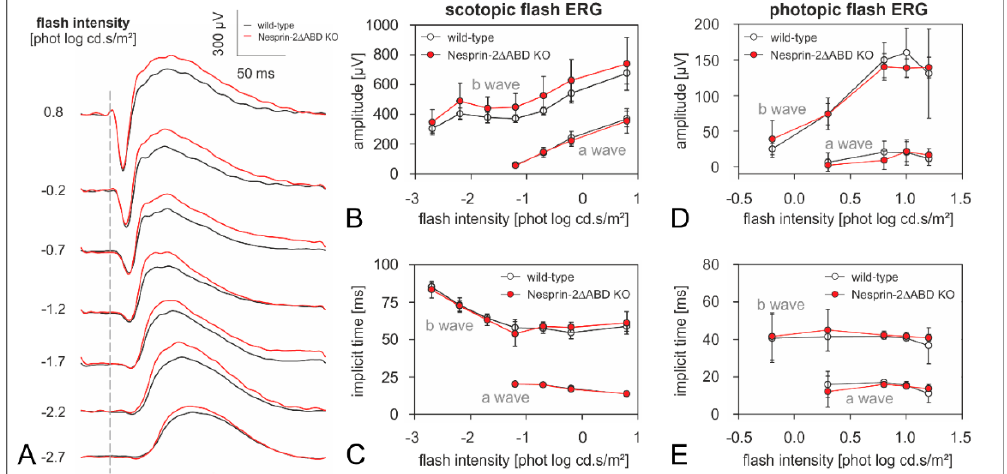
Figure 4. Parameter analysis of scotopic and photopic a- and b-wave in the retina of Nesprin-2 ∆ ABD mouse strain (age 2–4 month). ( A ) ERG responses without oscillatory potentials from wild-type (mean, black curves, n = 7) and Nesprin-2 ∆ ABD KO (mean, red curves, n = 7) mice evoked with di ff erent flash intensities (shown on the left). Dashed line indicates the time point of the stimulus flash. ( B ) Amplitude vs. flash intensity profiles of scotopic a- and b-wave (wild-type: mean ± sd, white symbols, n = 7; Nesprin-2 ∆ ABD KO: mean ± sd, red symbols, n = 7). ( C ) Implicit time vs. flash intensity profiles of scotopic a- and b-wave (wild-type: mean ± sd, white symbols, n = 7; Nesprin-2 ∆ ABD KO: mean ± sd, red symbols, n = 7). ( D ) Amplitude vs. flash intensity profiles of photopic a- and b-wave (wild-type: mean ± sd, white symbols, n = 7; Nesprin-2 ∆ ABD KO: mean ± sd, red symbols, n = 7). ( E ) Implicit time vs. flash intensity profiles of photopic a- and b-wave (wild-type: mean ± sd, white symbols, n = 7; Nesprin-2 ∆ ABD KO: mean ± sd, red symbols, n = 7). Unpaired t-tests revealed no significant di ff erences between wild-type and Nesprin-2 ∆ ABD KO (all p > 0.05).